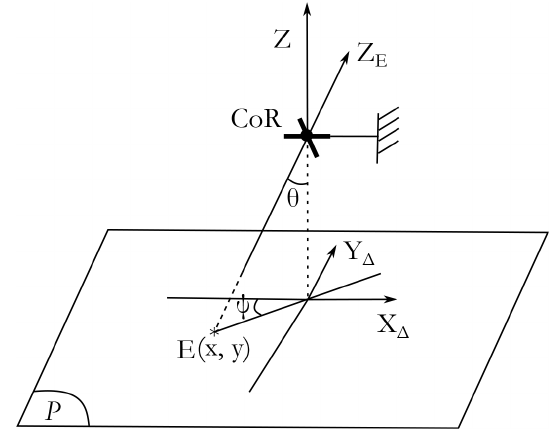
Figure 13. Determination of the PPM end-effector position using Euler angles ( ψ and θ